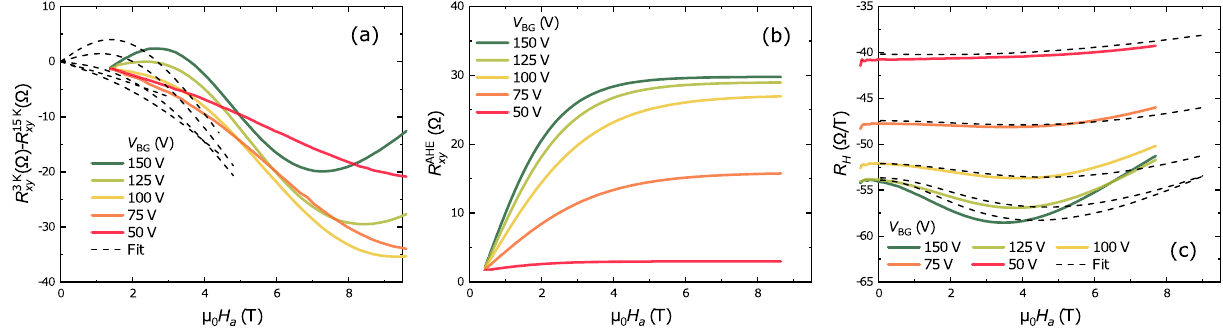
Figure 5. (a) Subtraction of the curves measured at 15 K and V BG as indicated from curves measured at 3 K (solid lines); and the fit with Eq. (6) (dashed lines). (b) Resulting AHE field dependence obtained from the fit (see text). (c) Measured Hall coefficients R H at 3 K and for different gate voltages V BG (solid lines) and the fit (dash lines).